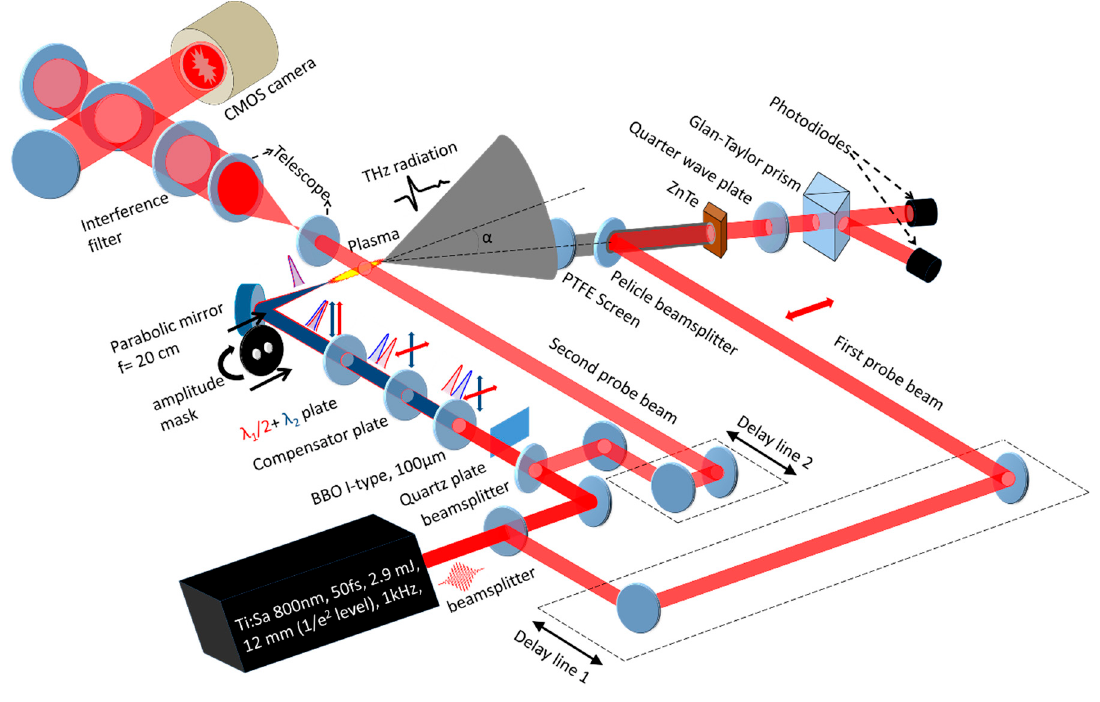
Figure 1. Experimental setup.